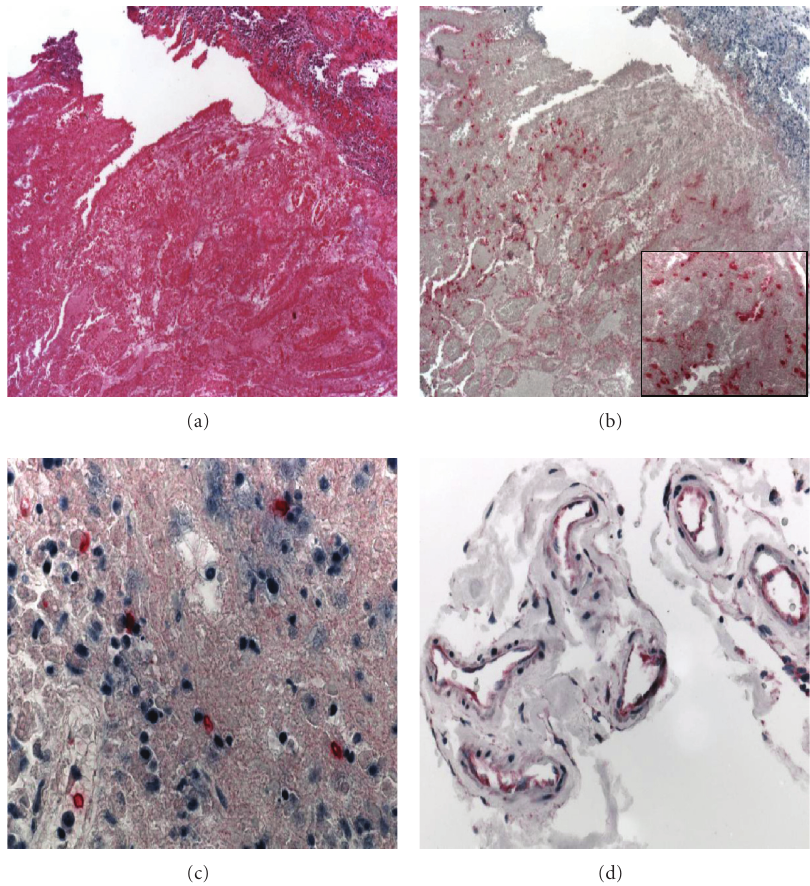
Figure 1: Histopathologic and immunohistochemical findings in representstive tissues of study patient. (a) Extensive necrosis of intestinal mucosa with di ff use, extensive, submucosal edema and multifocal inflammatory cell infiltrates (H&E, original magnification X13). (b) Abundant, di ff use immunostaining of Clostridium spp . antigens in intestine (original magnification X13; inset X100). (c) Immunohistochemical detection of P. falciparum HRP-2 antigens in pRBCs in spleen (original magnification X100). (d) HRP-2